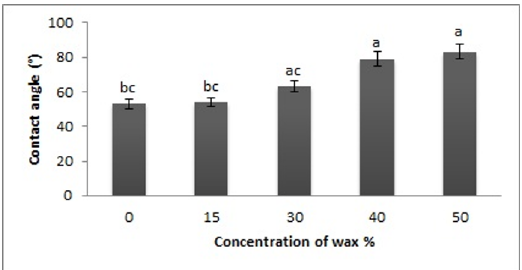
Figure 2. Mean values for contact angle as a function of the carnauba wax percentage in the lipid mixture for the different polymer: lipid ratios. Different lowercase letters mark significantly different mean